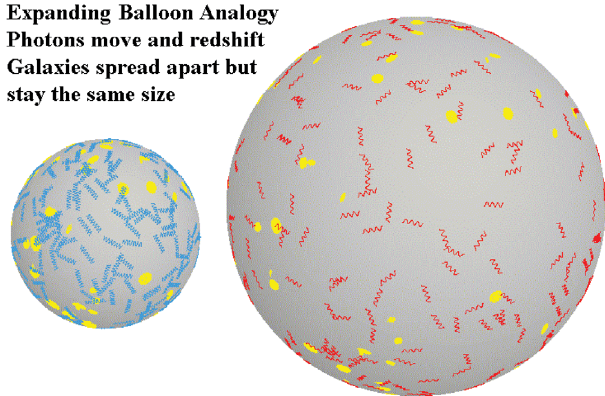
FIG. 25. Expanding balloon analogy showing the stretching of wavelength due to cosmological redshift. Image credit: http://